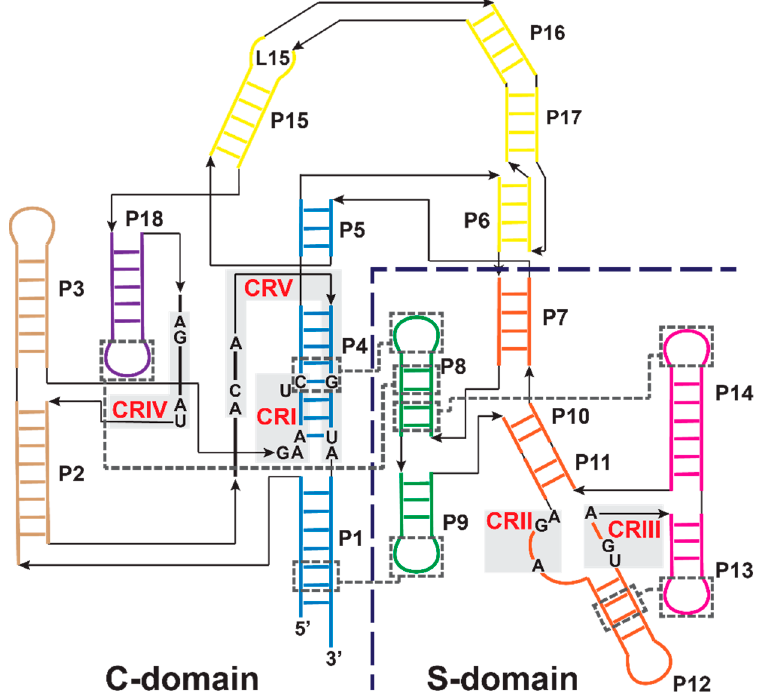
Figure 3. The secondary structure of type A RNase P RNA from T . maritima (adapted with permission from [21]) [22,23]. Individually-folding catalytic (C)- and specificity (S)-domains are divided by the dashed line. Conserved regions (CRI–V, red) are indicated by gray shading and numbered in order of occurrence from the 5’ end [4]. Tertiary interactions in the T . maritima P RNA are indicated by dashed gray boxes and lines. Helices are colored by coaxial-stack and are numbered as P1–P18 in order of occurrence from the 5’ end. The C-domain includes P1/P4/P5 (blue), P2/P3 (brown), P6/P15/P16/P17 (yellow,) and P18 (purple). The S-domain includes P7/P10/P11/P12 (orange), P8/P9 (green), and P13/P14 (pink).